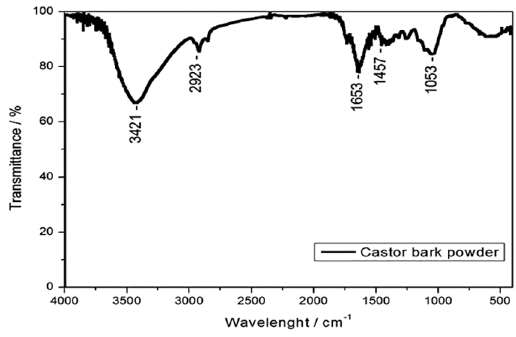
Figure 1. FTIR spectra of castor bark